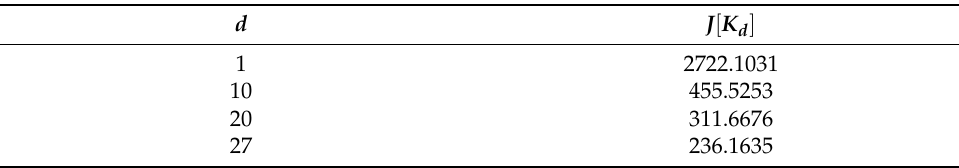
Table 2. Solution results for different mini-batch sizes.